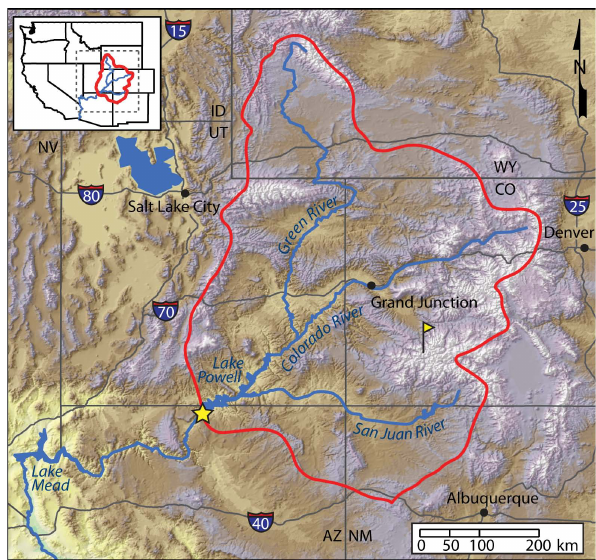
Fig. 1. Map of Upper Colorado River